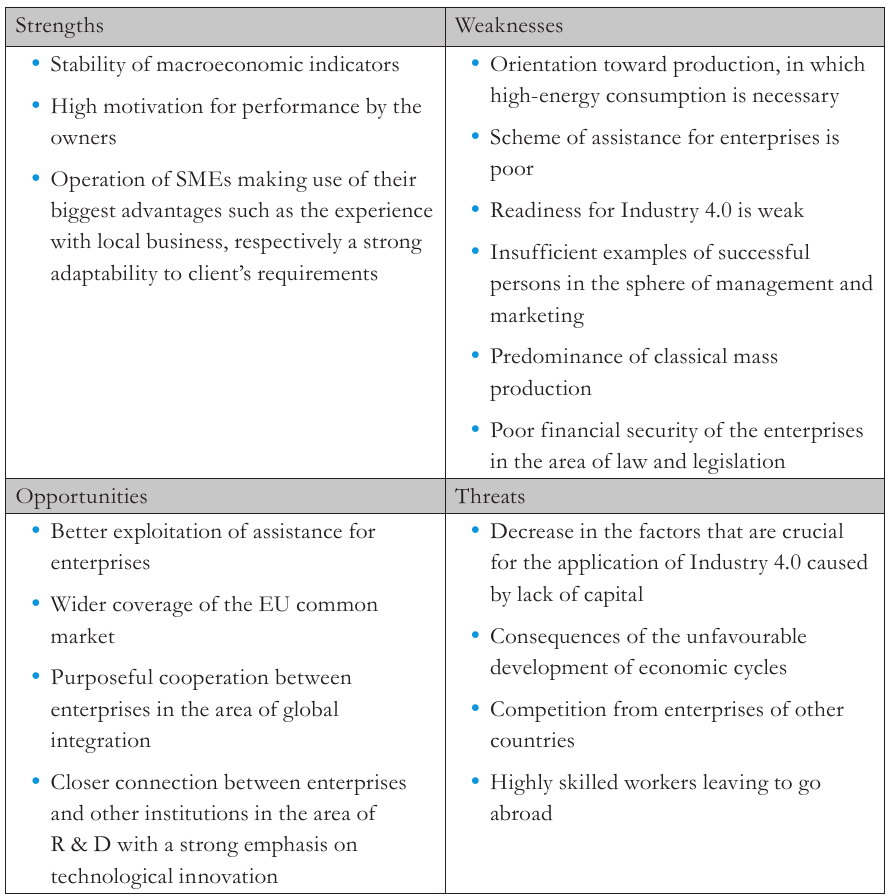
Tab. 3 – SWOT analysis of enterprise competitiveness in the Slovak Republic. Source: own